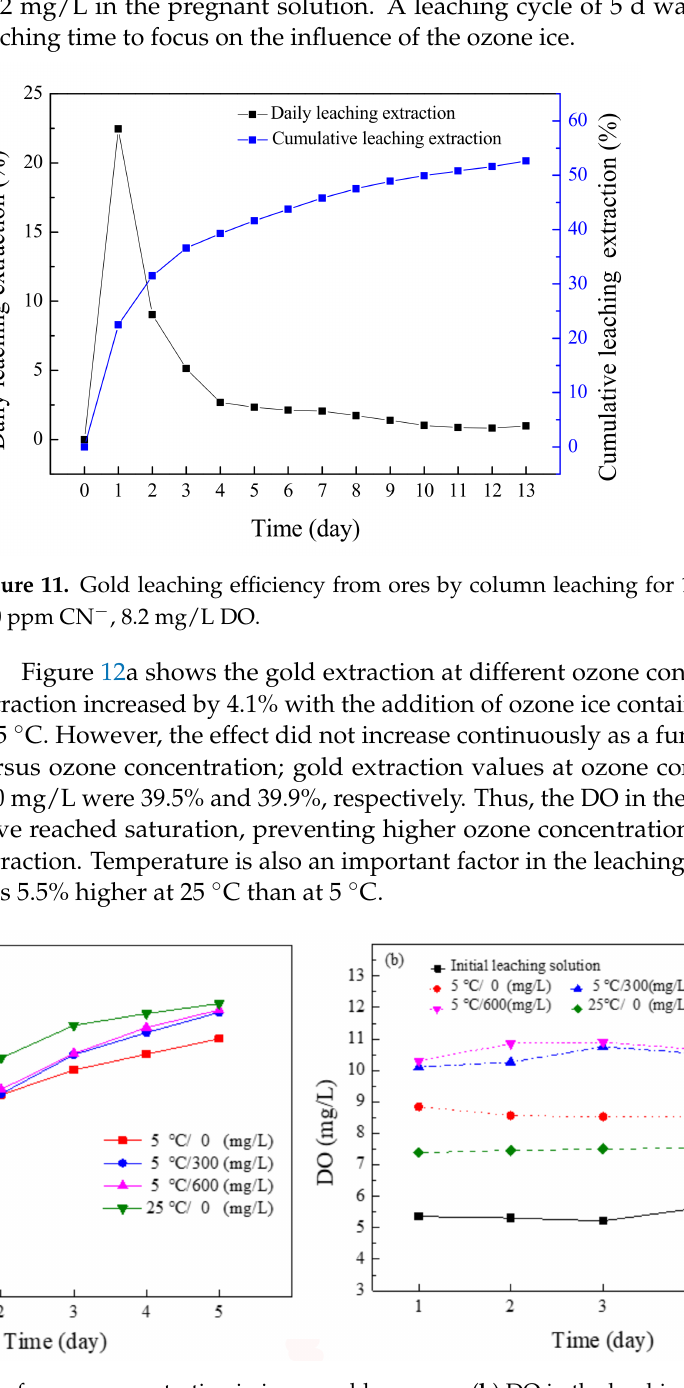
Figure 12. ( a ) Effect of ozone concentration in ice on gold recovery. ( b ) DO in the leaching